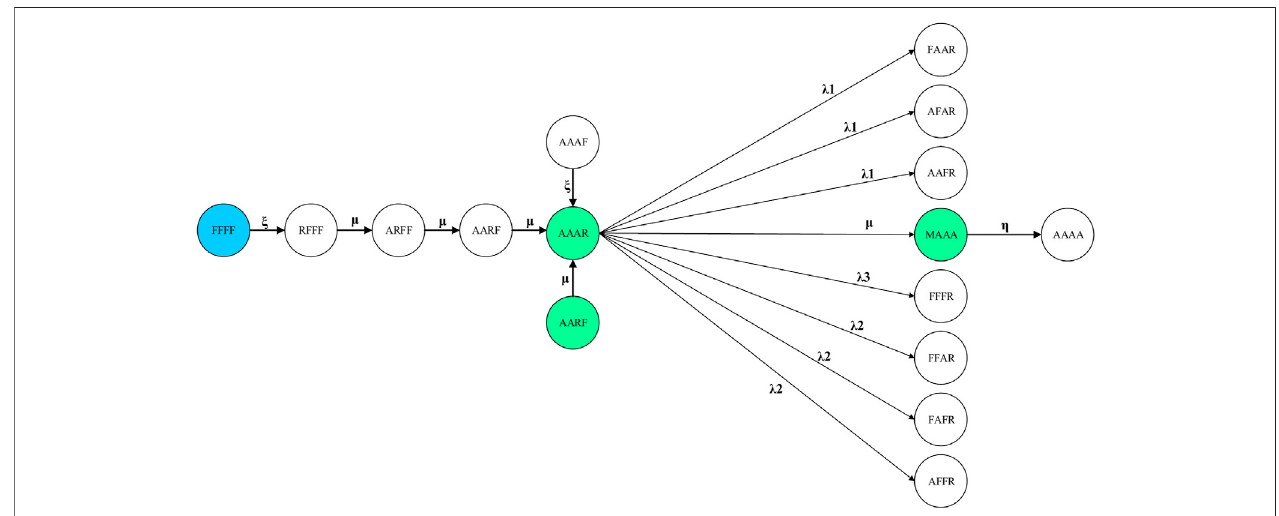
FIGURE 2 | Sample transition diagram of policy